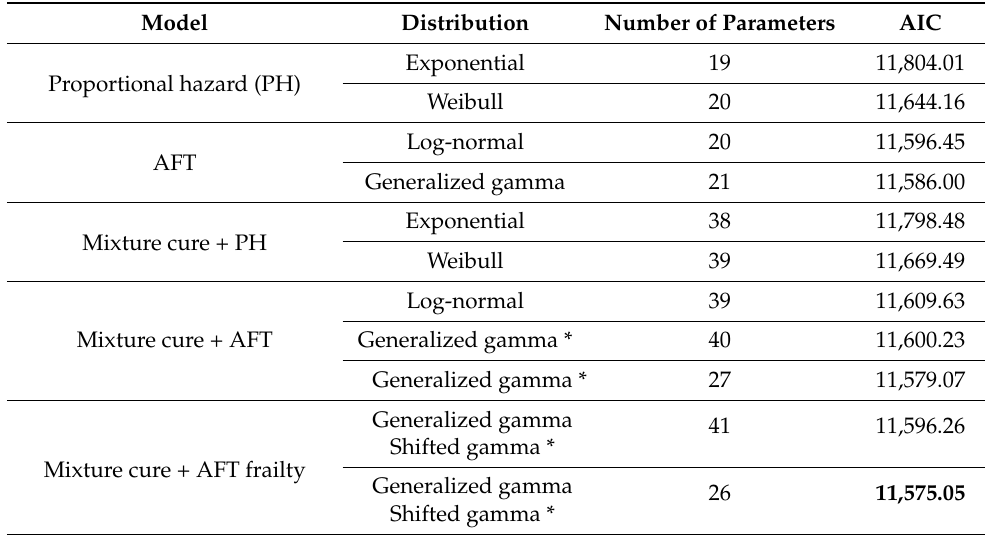
Table 5. AIC for the regression model of the onset of hypertension in females. The asterisk (*) represents that variable selection is performed for the uncured probability p ( Z )